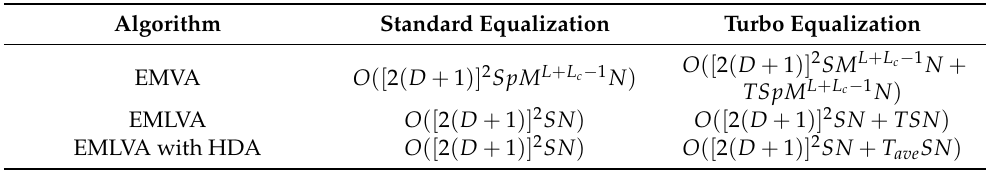
Table 2. Complexity comparison of the